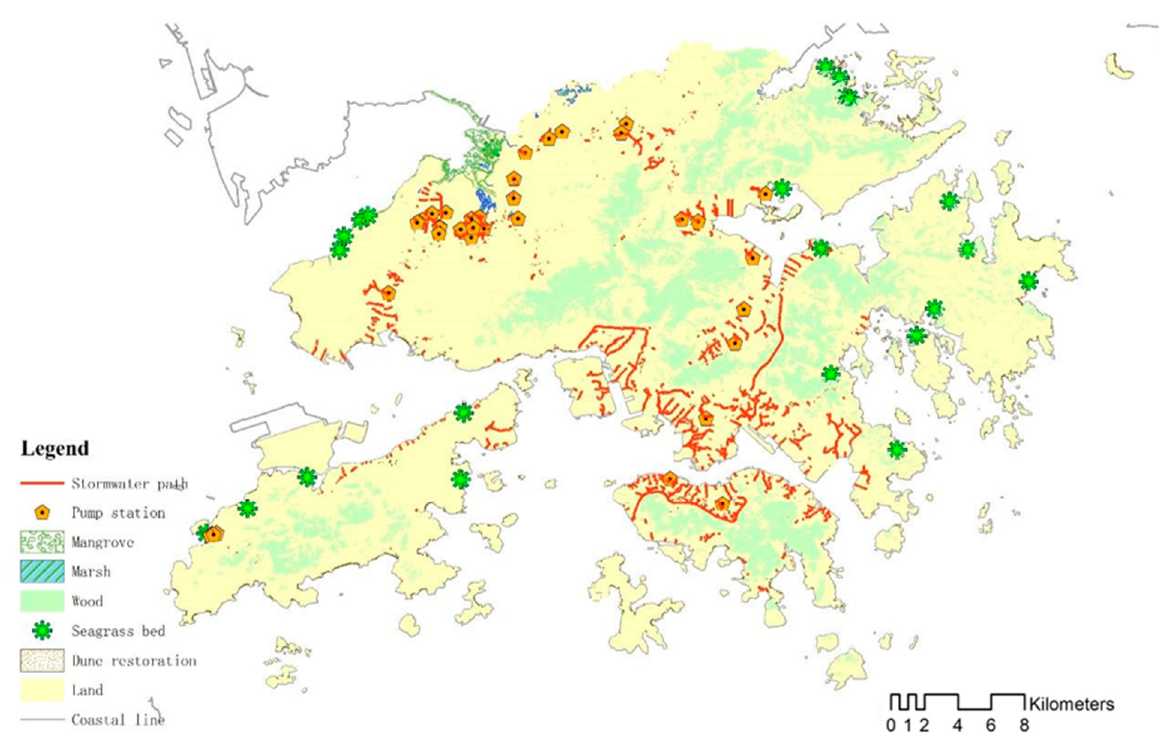
Figure A2. Distribution of constructed and green infrastructures.